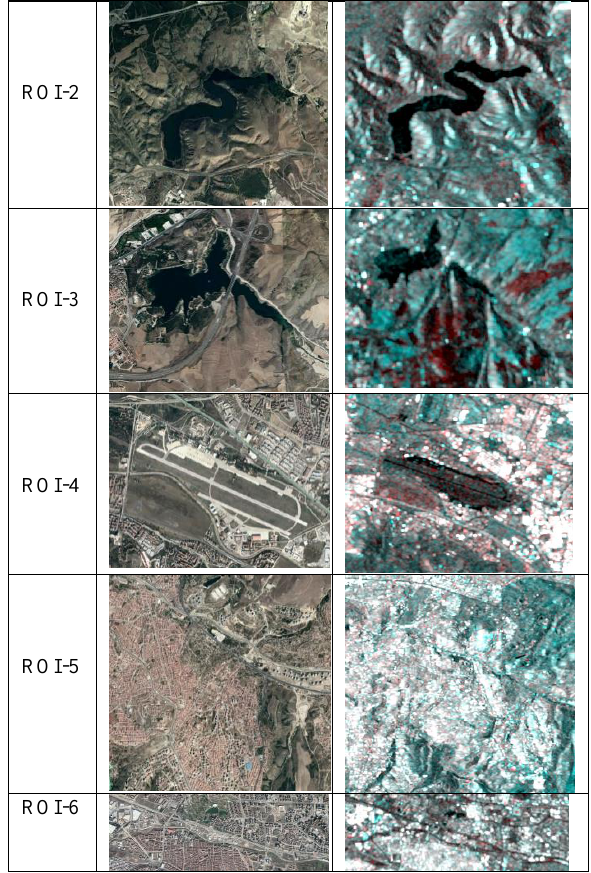
Figure 9. RGB maps produced from the Sentinel-1 data obtained right after the flood on May 5, 2018, in Ankara (right). Optical satellite images (credit: Google Earth) for the same ROIs (left). Light red (pink) and black areas denote water. The darker red is mostly seen on rugged topography and denote